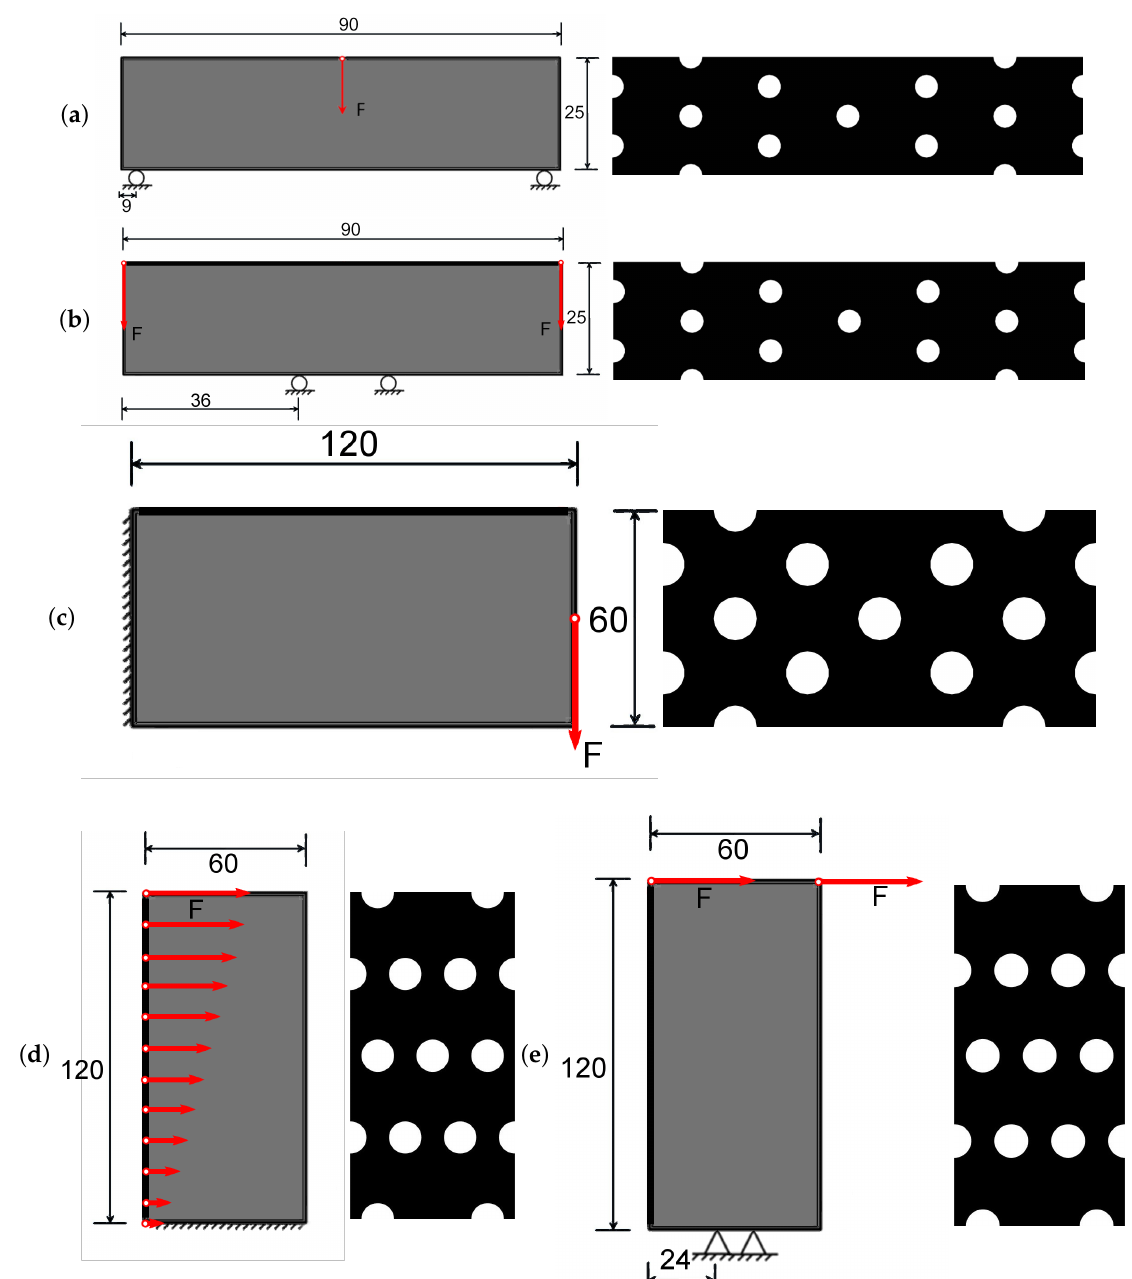
Figure 10. Optimization cases and initial assumptions: ( a ) the three-point bending beam case; ( b ) the beam is supported horizontally in two bottom points, and equal loads applied vertically in upper corners; ( c ) the cantilever beam case; ( d ) the beam is fixed along the bottom side, and the horizontal load linearly distributed along the left side of the beam; ( e ) the beam is fixed horizontally in two bottom points, and equal loads applied horizontally in upper